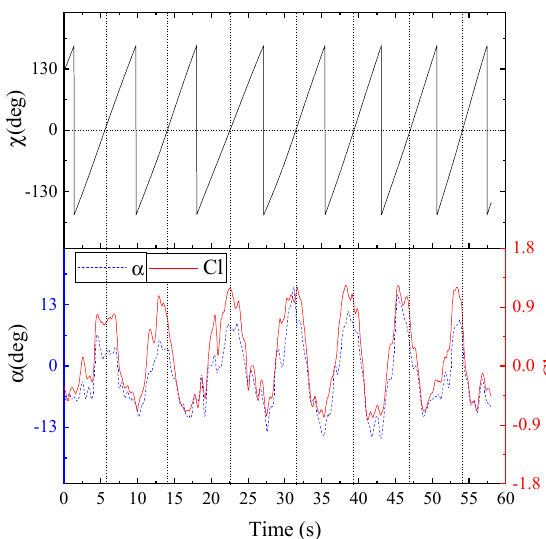
Figure 21. Time history of azimuth angle, angle of attack, and lift coefficient in Case 1. Appl. Sci. 2018 , 8 , x FOR PEER REVIEW